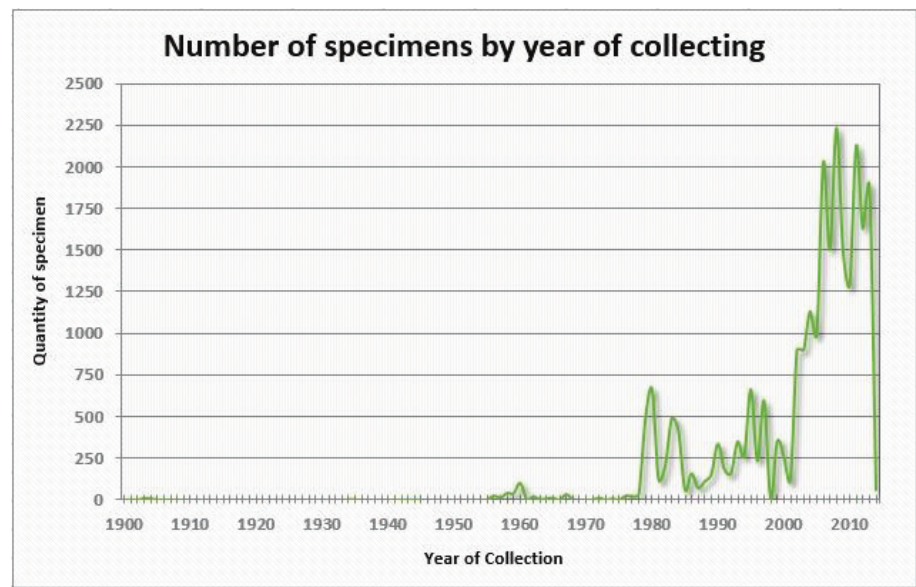
Figure 3. Distribution of the number of specimens collected by year.